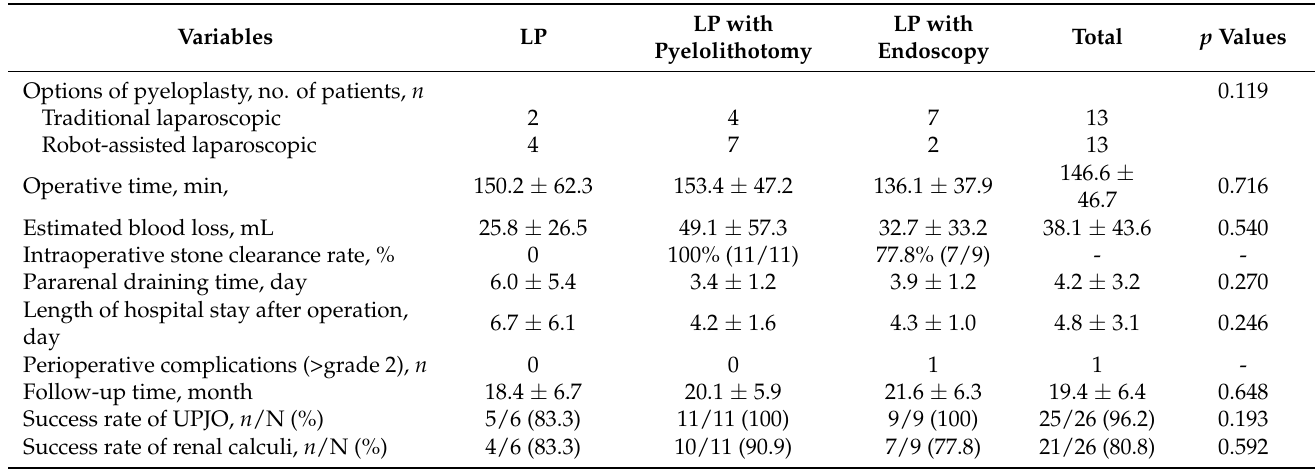
Table 2. Operative data and follow-up data of the patients.